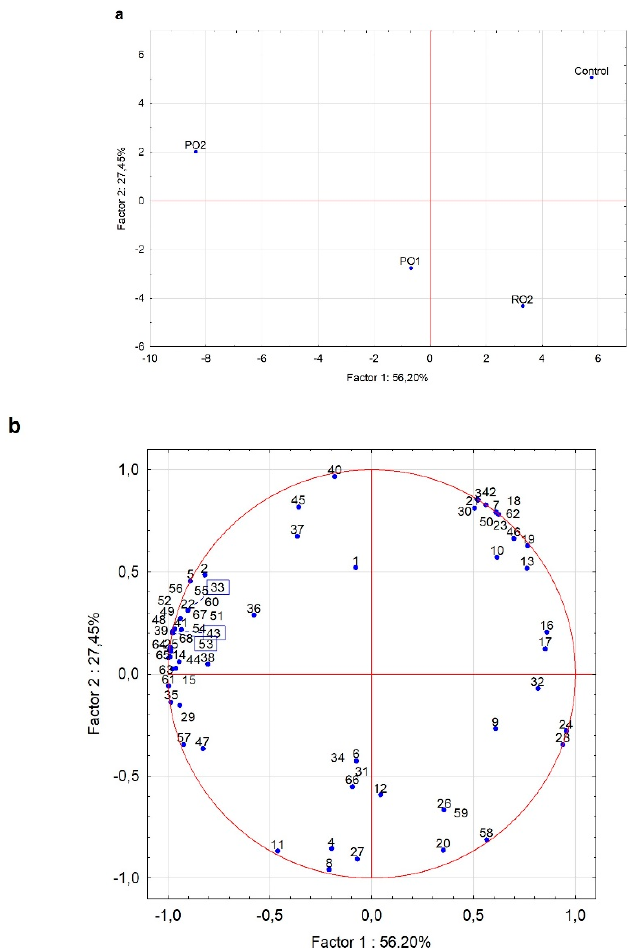
Figure 4. Projection on the factor plane (1 × 2) of caciotta whey inoculated with three different strains of Y. lipolytica (RO2, PO1, PO2) and incubated for 72 h. The control was represented by caciotta whey without Y. lipolytica . ( a ) Treatments; ( b ) Variables. 1: 4 − methyl − octane; 2: 2,4 − dimethyl − 1 − hep-